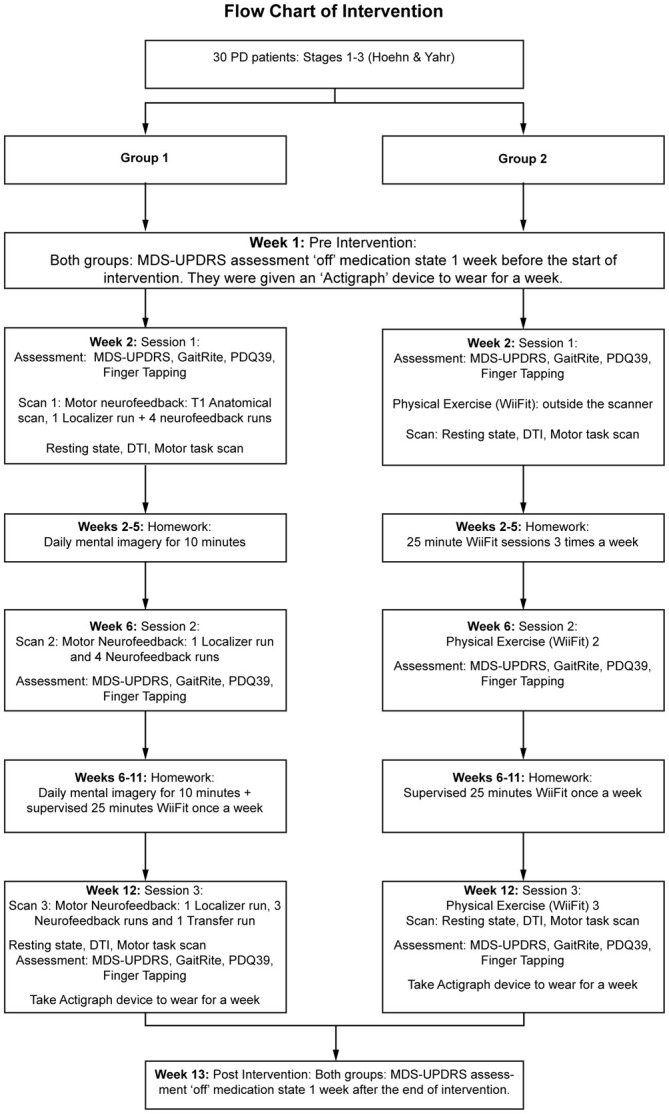
Flowchart of the study design with details of the interventions.